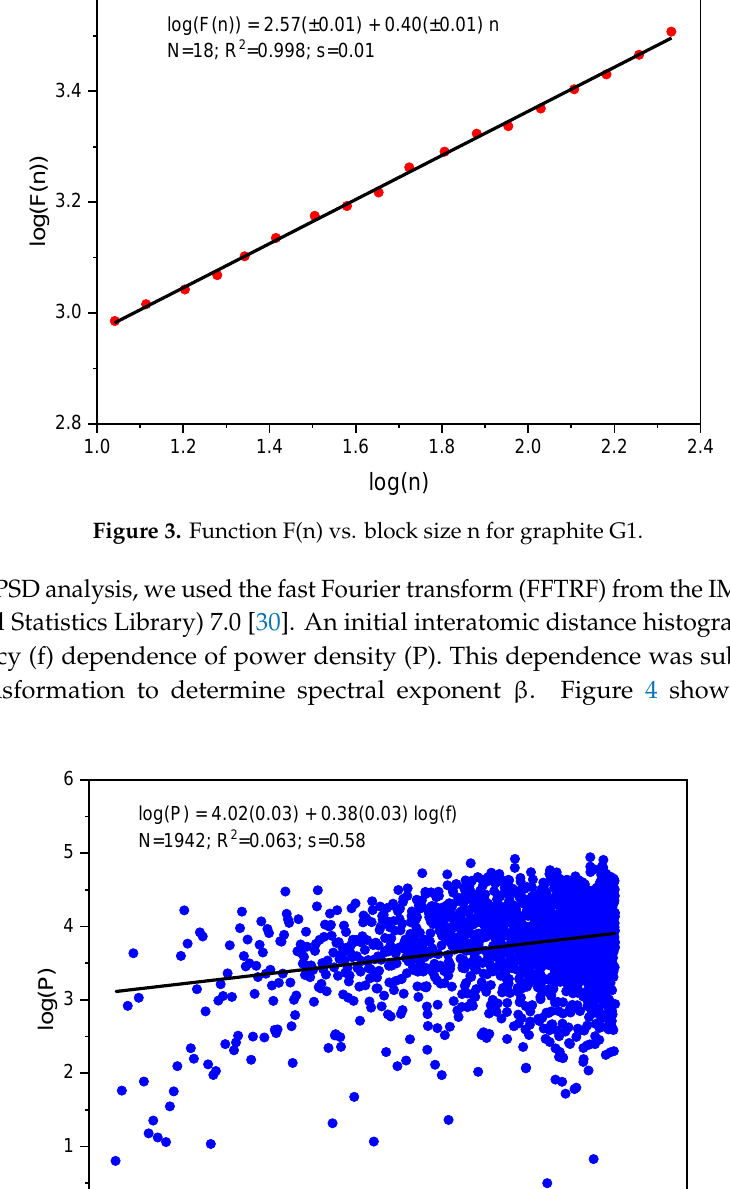
Figure 4. Power spectrum of diamond D2.